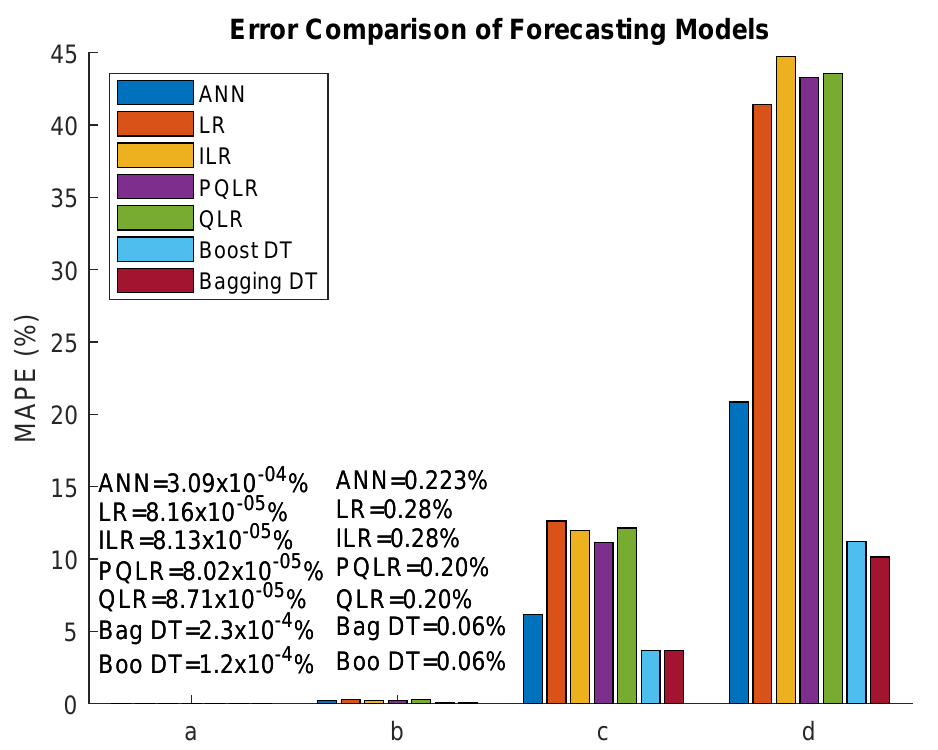
Figure 12. Comparison of the error results for the forecasting models, a, b, c, d for frequency, voltage, THDu , and THDi ,